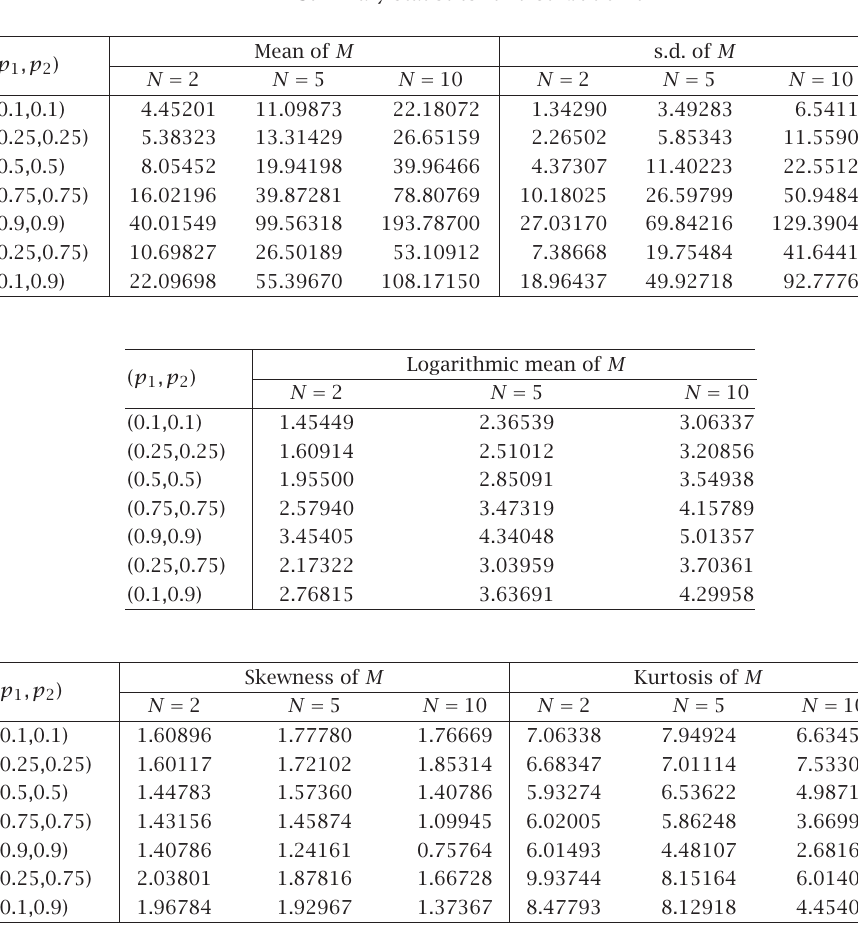
Table 4.2 Summary statistics for distribution of M